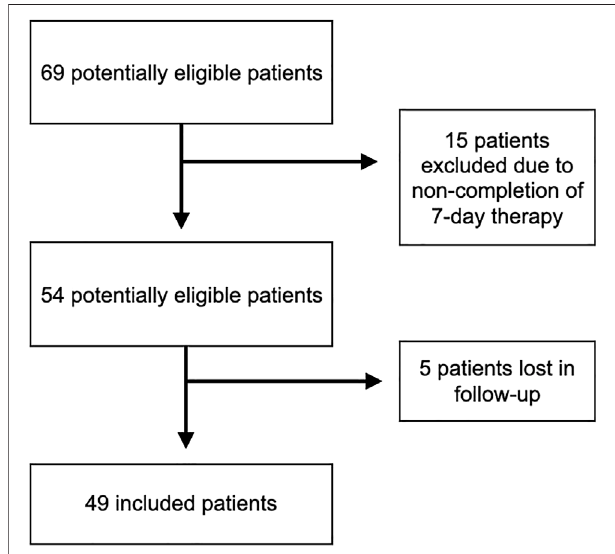
FIGURE1| Flowchartdescribing theselectionofpatients forinclusionin the study. The number of patients excluded and the reasons for exclusion from the study are